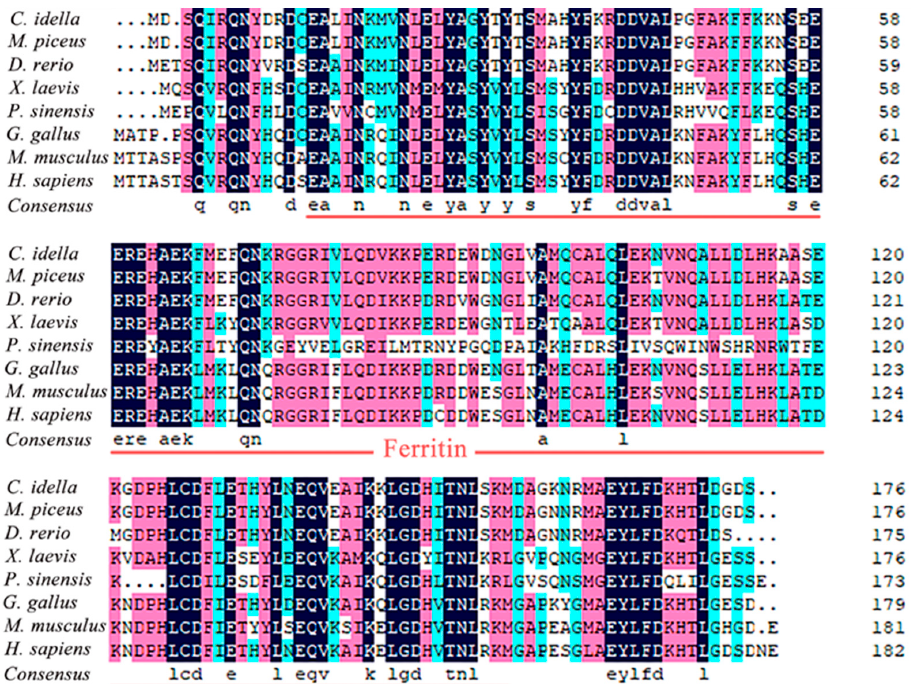
Figure 2. Multiple sequence alignment of Ciferritin with other homologs. The functional domain of ferritin was underlined.